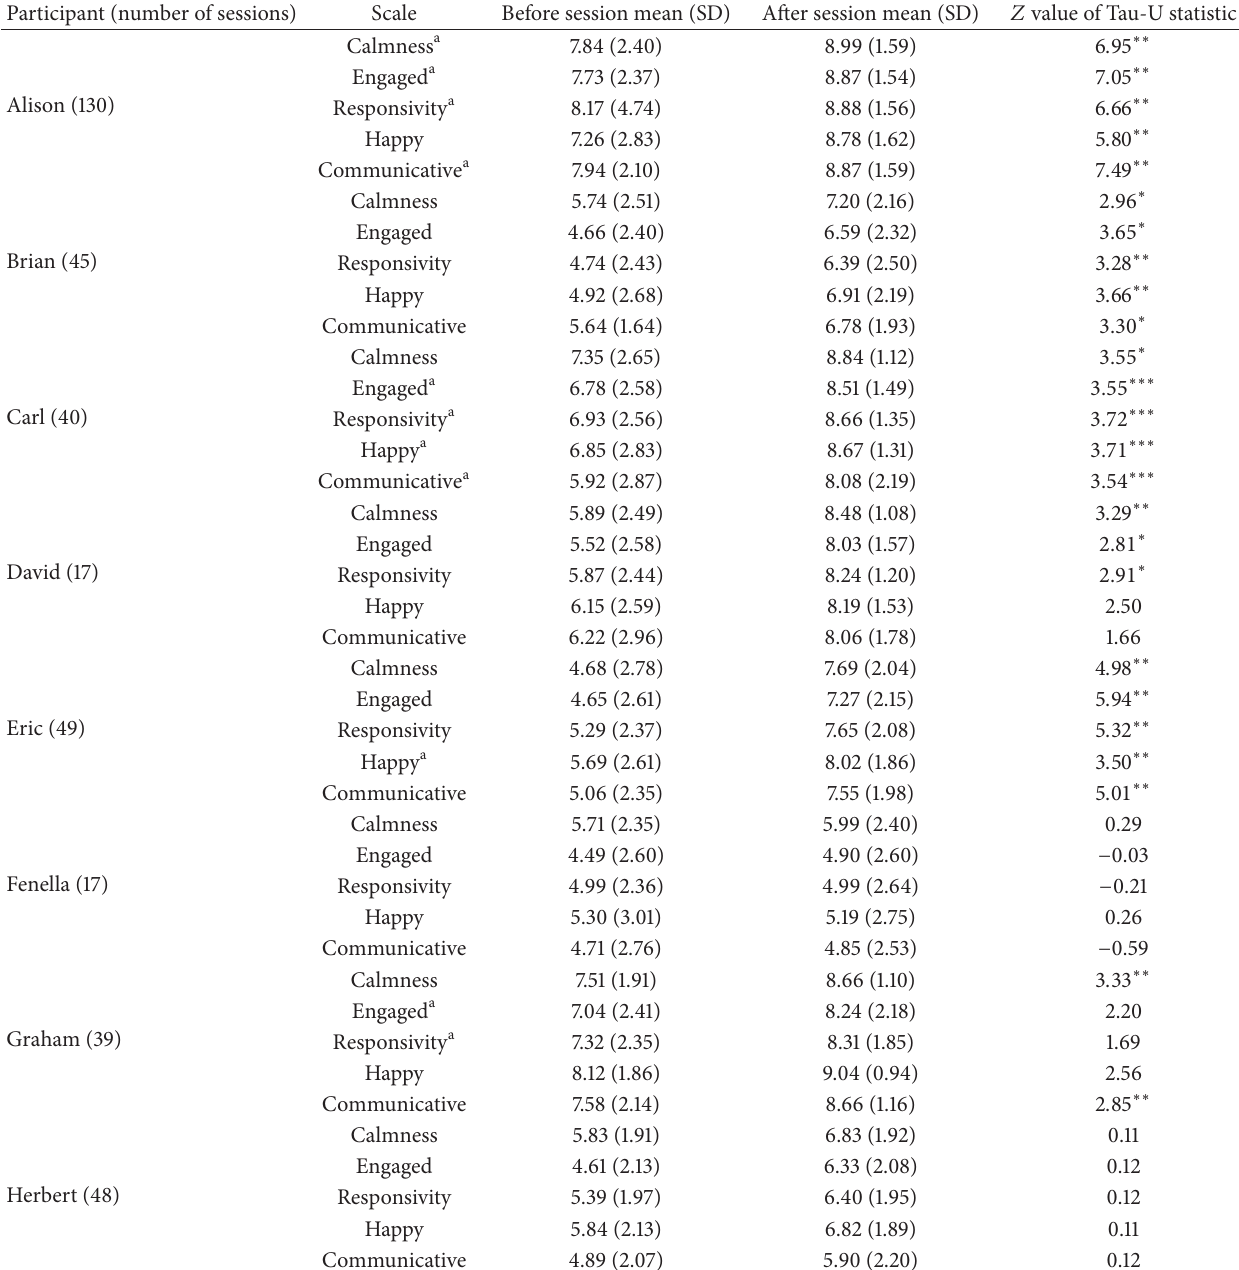
Table 2: Means and standard deviations recorded for the scales before and after deep pressure